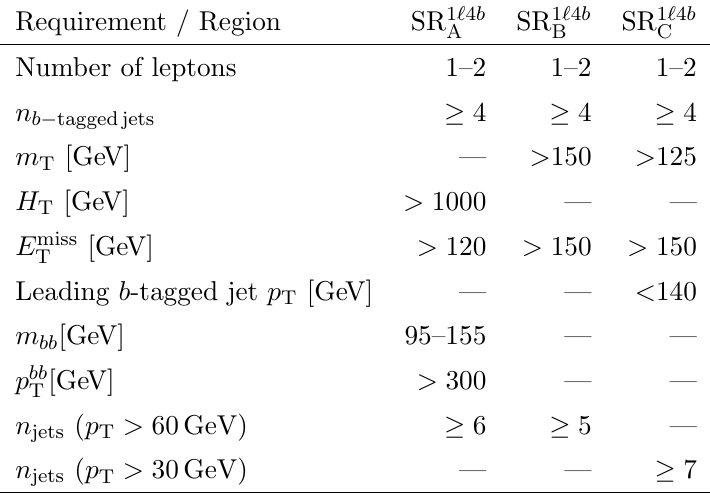
Table 3. De(cid:12)nition of the signal regions used in the 1 ‘ 4 b selection (see text for details). to satisfy the t ight likelihood-based identi(cid:12)cation requirement as de(cid:12)ned in refs. [74, 75]. These SRs are de(cid:12)ned as shown in table